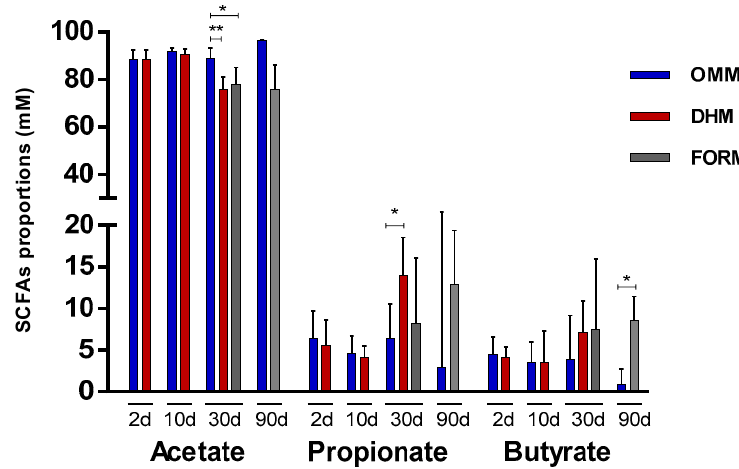
Figure 4. Proportions (% in mM) of the main short-chain fatty acids (SCFAs) determined by gas chromatography (GC) in the feeding type groups. Median and IQR range values are represented. OMM: own mother’s milk; DHM: donor human milk; FORM: formula milk group. * indicates a significant difference (* p < 0.05; ** p < 0.01).